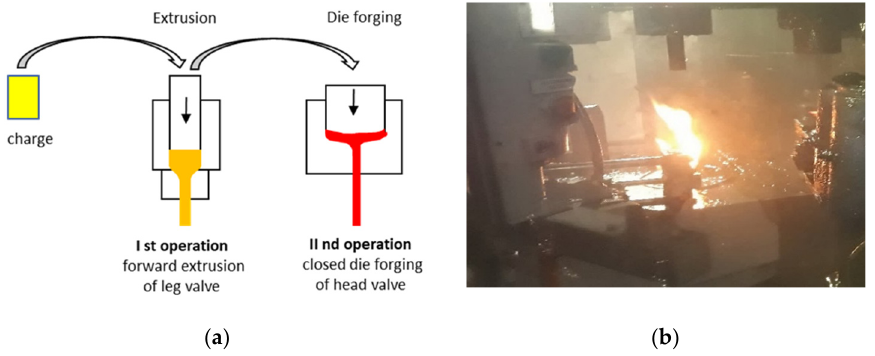
Figure 5. View of: ( a ) a diagram of the analyzed hot extrusion and forging technology, ( b ) a photo- graph of the press chamber in an industrial forging process with visible flames resulting from burn- ing out of the oil in contact with the hot forging in the die.